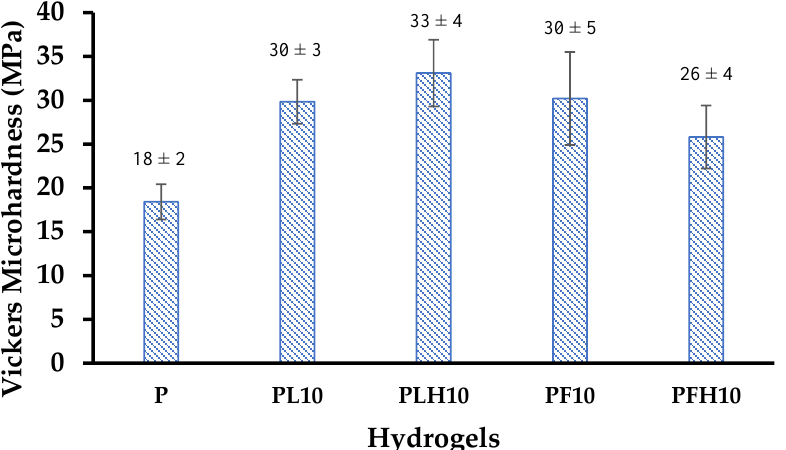
Figure 23. Vickers microhardness of modified and unmodified hybrid hydrogels, with 10% inorganic phase.